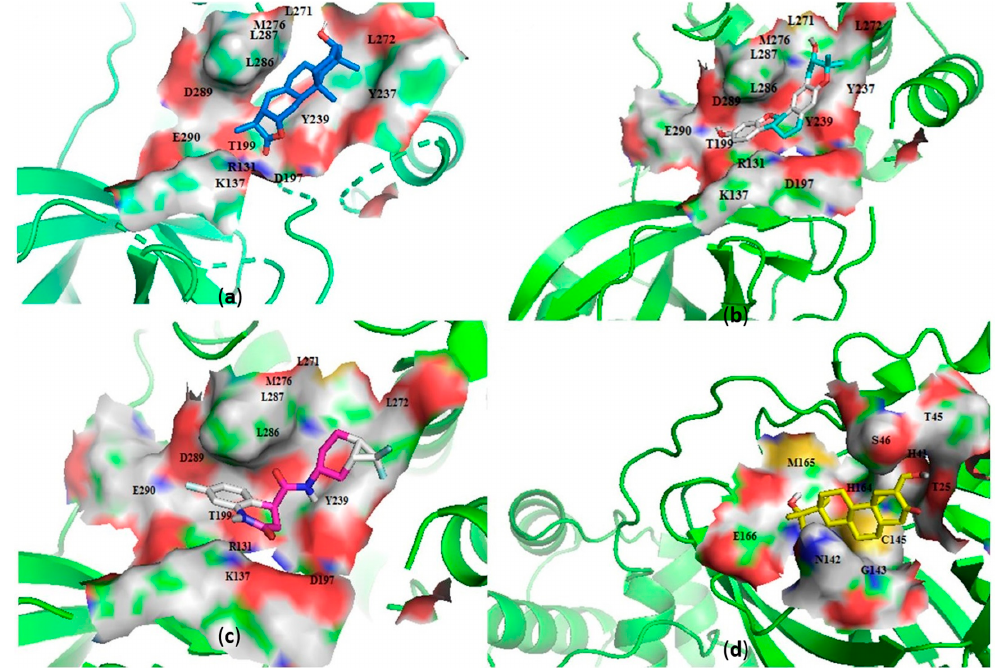
Figure 2. Cartoon representation of the main protease (M pro ) in complex with: ( a ) NANPDB2245 (helioscopinolide B), ( b ) ZINC000095486008, ( c ) ZINC001645993538, and ( d ) oxymetholone. The binding sites are shown as a surface representations, with the ligands shown as sticks. Molecules 2021 , 26 , x FOR PEER REVIEW